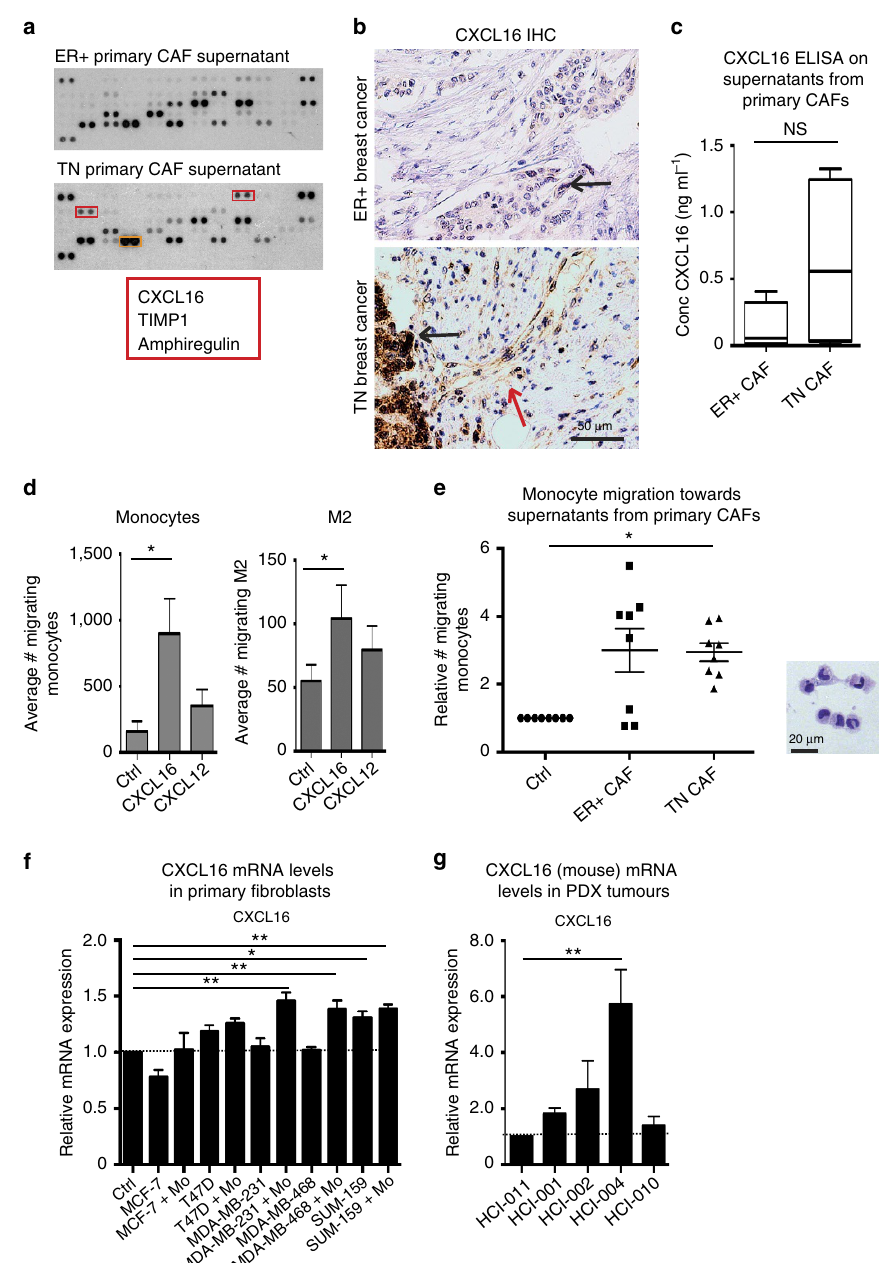
Figure 6 | CXCL16 expression is induced in fibroblasts by myeloid cells. ( a ) Human angiogenesis array proteome profiler of supernatants from primary CAFs derived from ER þ or ER (cid:2) PR (cid:2) Her2 (cid:2) (triple negative; TN) tumours. ( b ) IHC of CXCL16 in human primary breast cancers. Upper panel shows ER þ PR þ breast cancer and lower panel one TNBC. Black arrow highlights CXCL16 expressing malignant cells and red arrow, CXCL16 expressing fibroblasts. ( c ) The levels of secreted CXCL16 were measured using a human CXCL16 ELISA performed on supernatants prepared from primary human CAFs isolated from TN or ER þ primary breast tumours. N ¼ 4 TN and N ¼ 8 ER þ . Mann–Whitney U -test. ( d ) Migration of primary human monocytes (left) or M2 macrophages (right) was measured using Boyden migration chambers with 8 m m pore size towards control medium (Ctrl), recombinant CXCL16 or CXCL12 as a control. * ¼ P o 0.05. ANOVA Dunn’s multiple comparisons test. N ¼ 5 and N ¼ 14. ( e ) Migration of primary human monocytes (left) or M2 macrophages (right) was measured using Boyden migration chambers with 8 m m pore size towards control medium (Ctrl), or towards conditioned medium from primary human CAFs derived from either ER þ or TN tumours. * ¼ P o 0.05 ** ¼ P o 0.01. ANOVA Dunn’s multiple comparisons test. N ¼ 8. The HE image (right) shows that the migrated cells are indeed monocytes and the scale bar represents 20 m m. ( f ) RT-QPCR analysis of CXCL16 levels in primary mouse fibroblasts cultured in either control medium (Ctrl) or supernatants derived from luminal A (MCF-7 and T47D) or TN (MDA-MB-231, MDA-MB-468 and SUM-159) breast cancer cells with or without co-culture with primary human monocytes (Mo). * ¼ P o 0.05 ** ¼ P o 0.01. ANOVA Dunn’s multiple comparisons test. N ¼ 4–8. Error bars indicate s.e.m. ( g ) RT-QPCR analysis of infiltrating mouse cell CXCL16 levels in human PDX tumours derived from one luminal (HCI-011; set to 1) and four TN (HCI-001, 002, 004, 010) breast tumours. ** ¼ P o 0.01. ANOVA Dunn’s multiple comparisons test. N ¼ 6–7. Error bars indicate